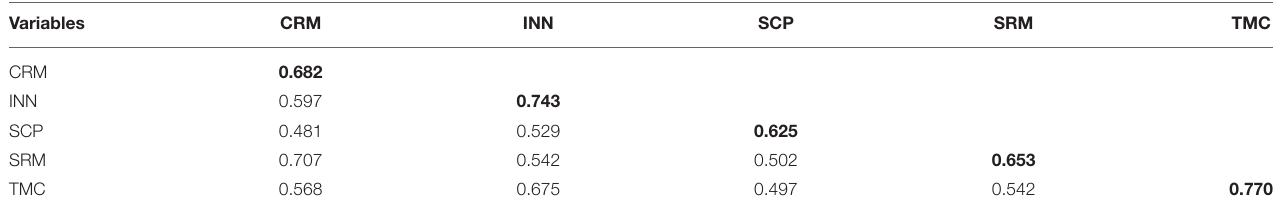
TABLE 3 | Intercorrelation between customer relationship management, innovation, supply chain performance, supplier relationship management, and top management commitments ( N = 208). Variables